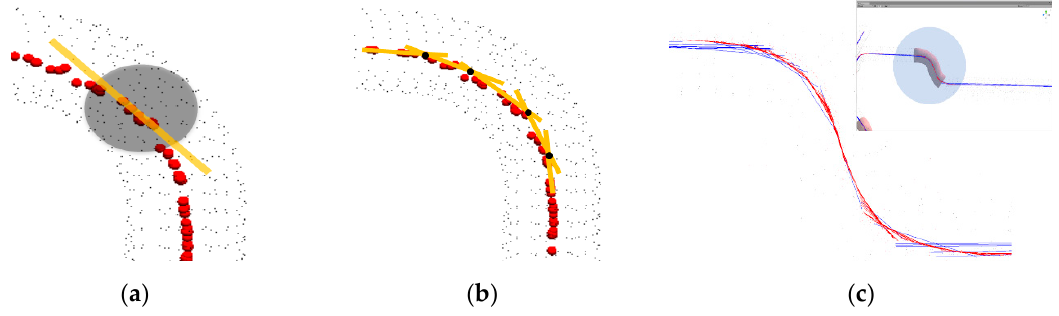
Figure 7. Control point estimation using PCA: ( a ) estimation of the tangent line at one point; ( b ) estimation of the spline control point using intersections of the tangent lines; ( c ) the curve matching result.